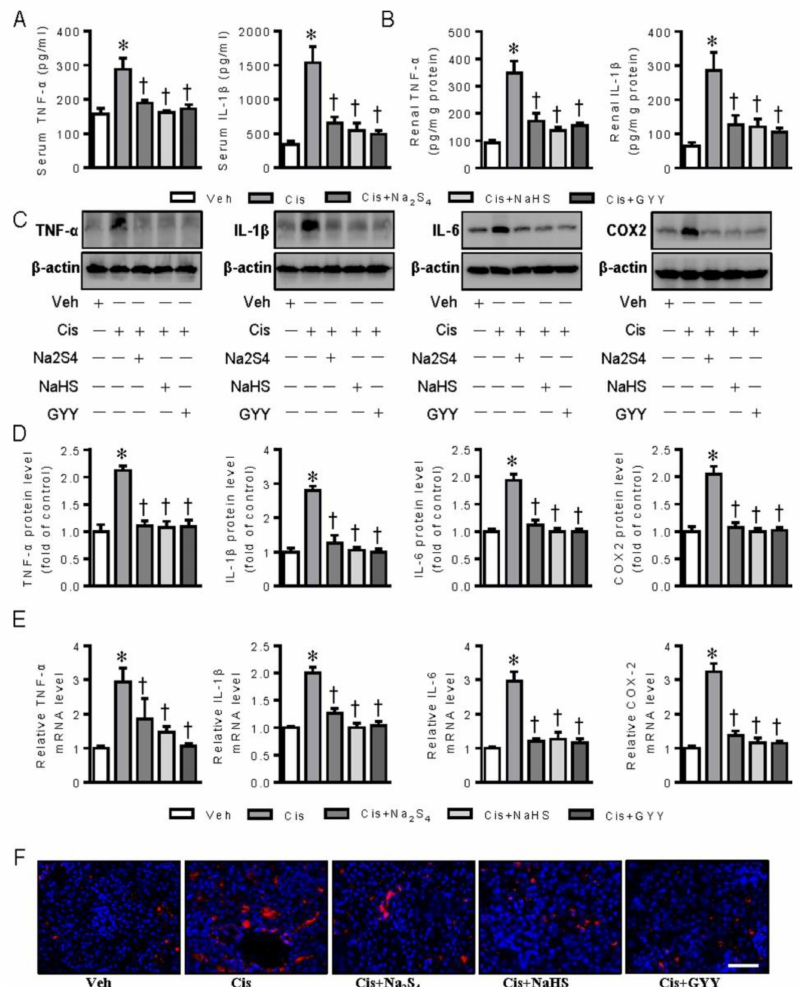
Figure 5. Polysulfide and H 2 S attenuated cisplatin-induced renal inflammation. ( A ) Serum levels of TNF- α and IL-1 β . ( B ) Renal levels of TNF- α and IL-1 β . ( C ) Representative blots of TNF- α , IL-1 β , IL-6, and COX-2 in renal tissues. ( D ) Quantitative analysis of TNF- α , IL-1 β , IL-6, and COX-2. ( E ) Relative mRNA levels of TNF- α , IL-1 β , IL-6, and COX-2. ( F ) Representative immunofluorescence staining of macrophage marker F4 / 80. Scale bar = 20 µ m. * p < 0.05 vs. Vehicle (Veh), † p < 0.05 vs. Cisplatin (Cis). GYY4137 (GYY). n = 5 in each